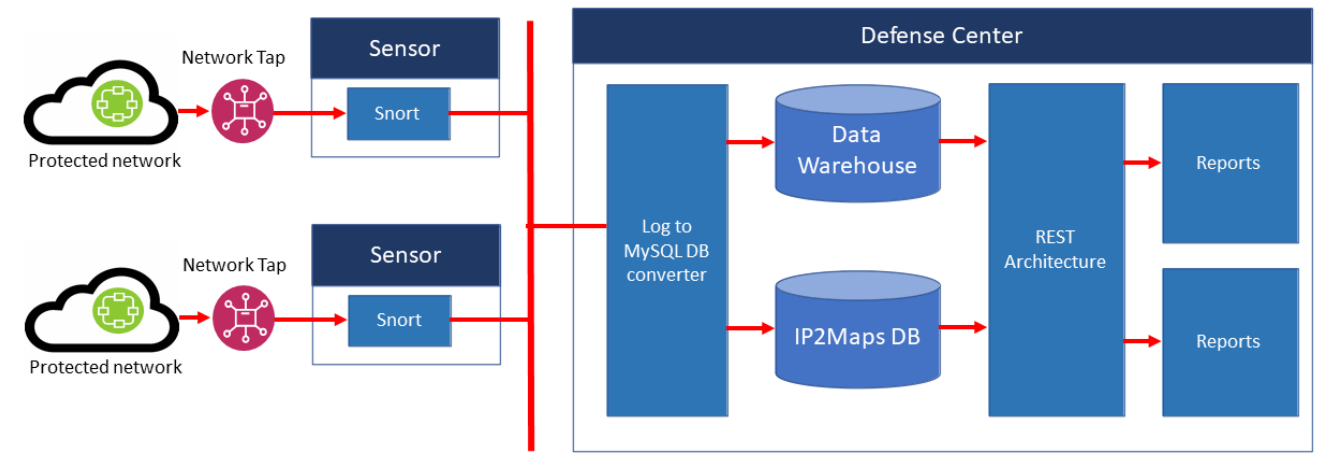
Figure 1. The topology of Mata Garuda, the Indonesia intrusion detection system based on Snort NIDS at the ID ‐ SIRTII/CC (2014–2015).